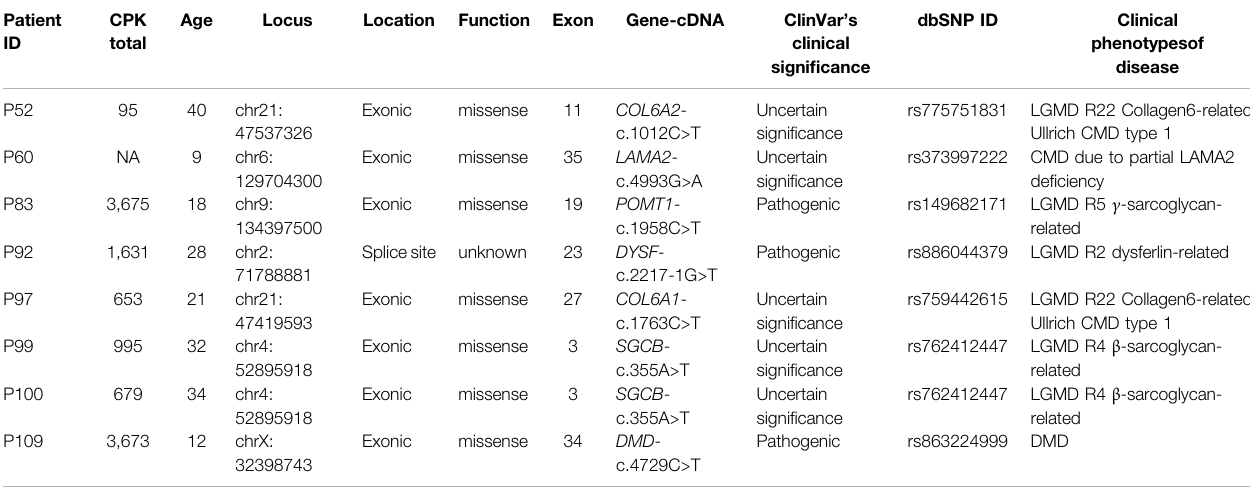
TABLE 1 | Summary of point mutations in LGMD and UMD cases identi fi ed using panel-based NGS sequencing. Patient